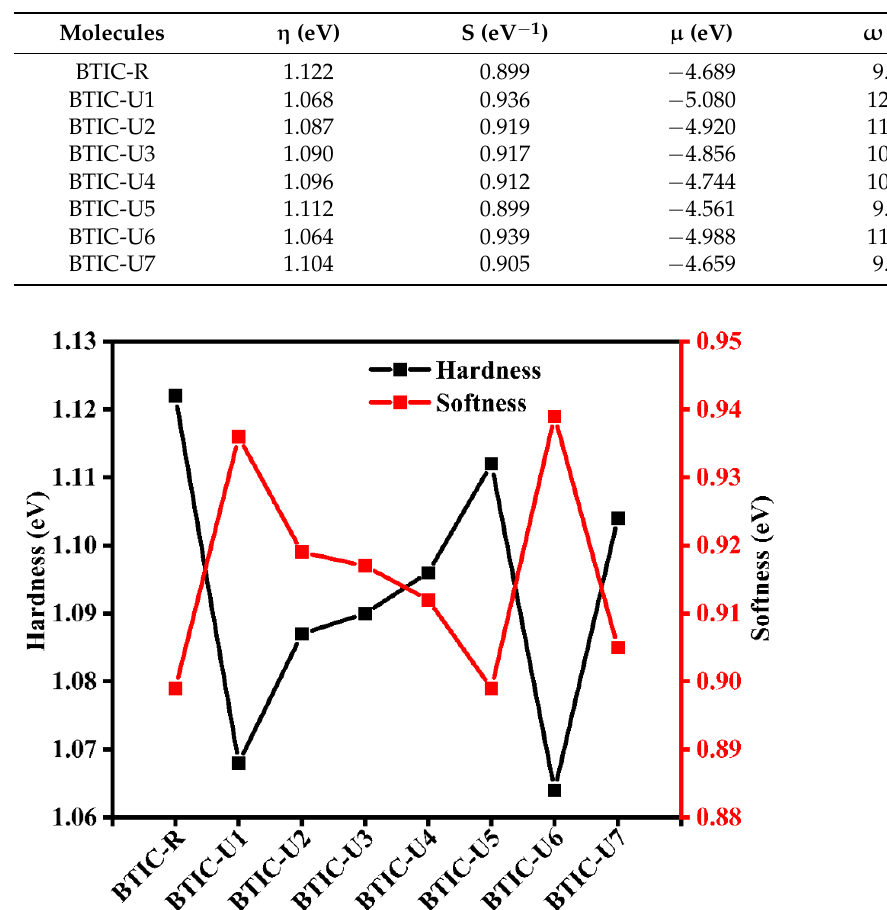
Figure 10. Hardness and softness of all the reference and newly designed molecules.